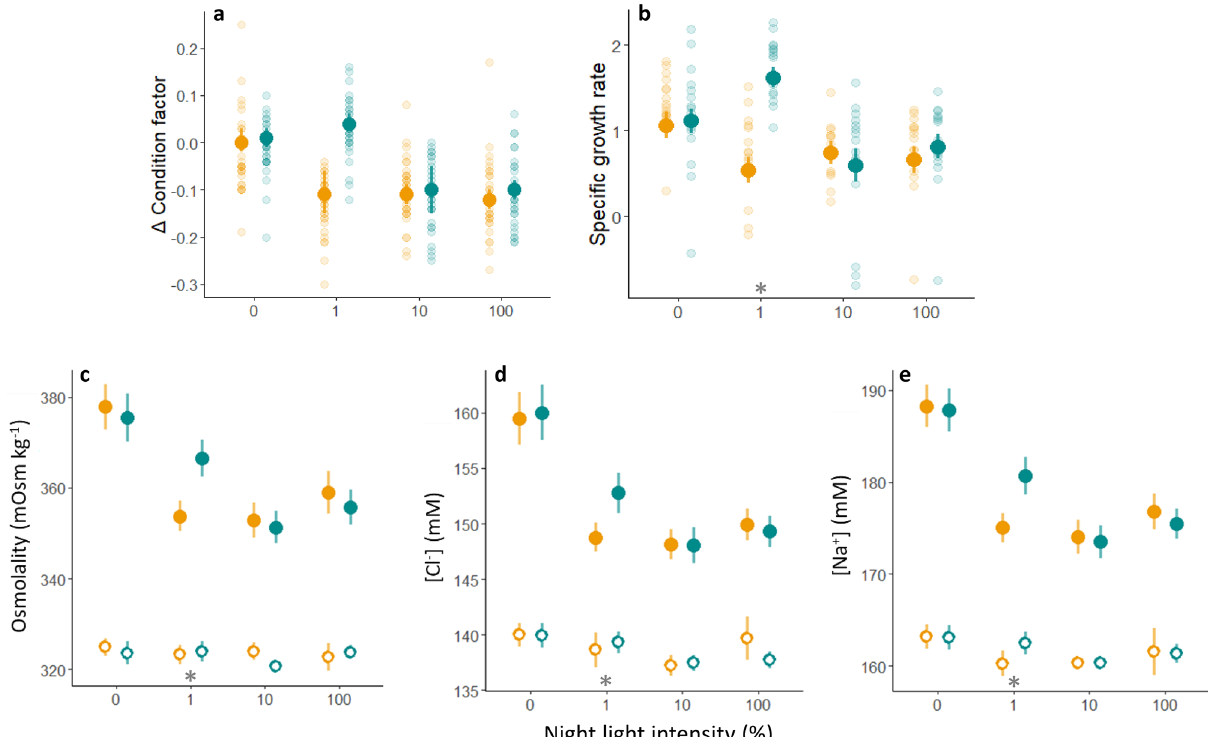
Figure 5. Impact of light treatment on smoltification. Fish status ( a : Δ condition factor, b : specific growth rate) and plasma parameters ( c : osmolality, d : [Cl − ], e : [Na + ]) after 22 days of exposure to light treatments. Solid points and error bars display the means ± 95% confidence intervals from GLMMs, while faded points present the individual measurements after 24 h acute exposure to 34.5 ppt seawater. Open points display the means ± 95% confidence intervals from control samples collected in freshwater. High light intensity groups are presented in orange, while the low light intensity groups are presented in green. *Denotes a significant difference between the high and low light intensity treatments after the saltwater